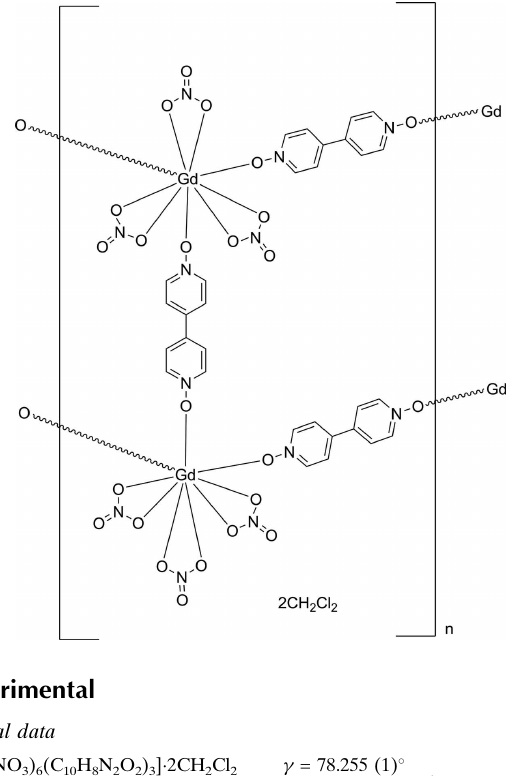
Related literature